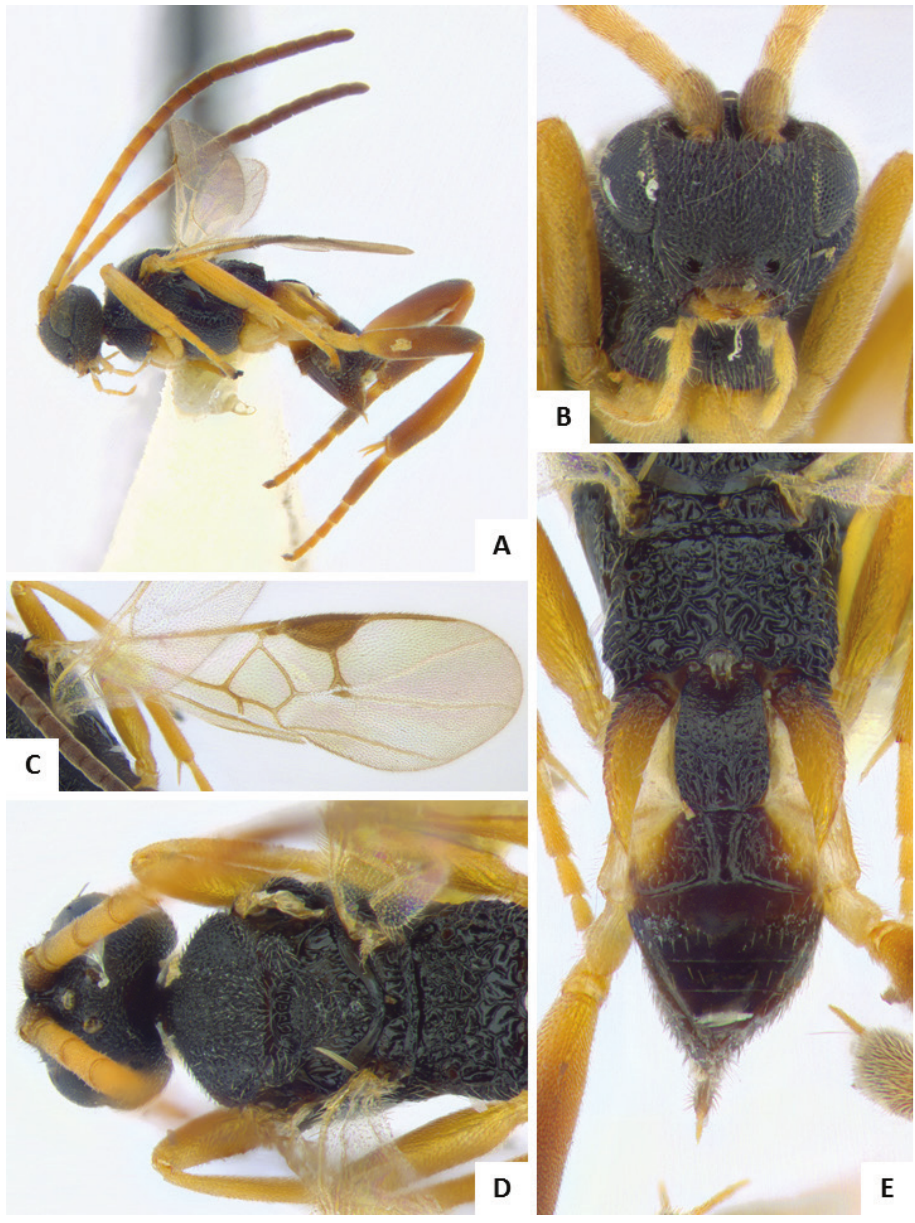
Figure 39. Rasivalva rugosa. A Habitus, lateral B Head, frontal C Wings D Metasoma, dorsal E Head and mesosoma,